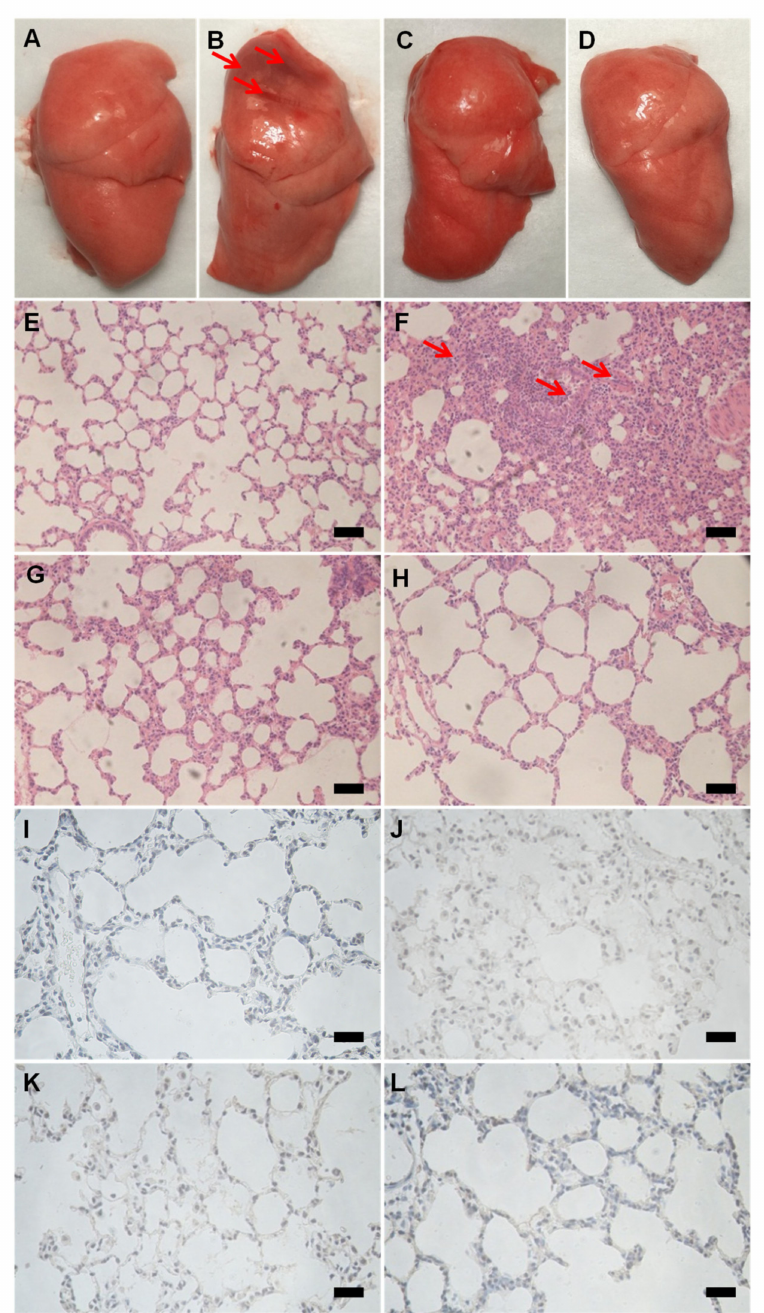
Figure 4. Appearance, H&E images and caspase-3 staining of the lung tissues from the healthy rats ( A , E , I ), the H 2 O 2 -induced ALI rats ( B , F , J ), the DXM group ( C , G , K ), and the JNDs group ( D , H , L ). The scale bars indicate 100 µ